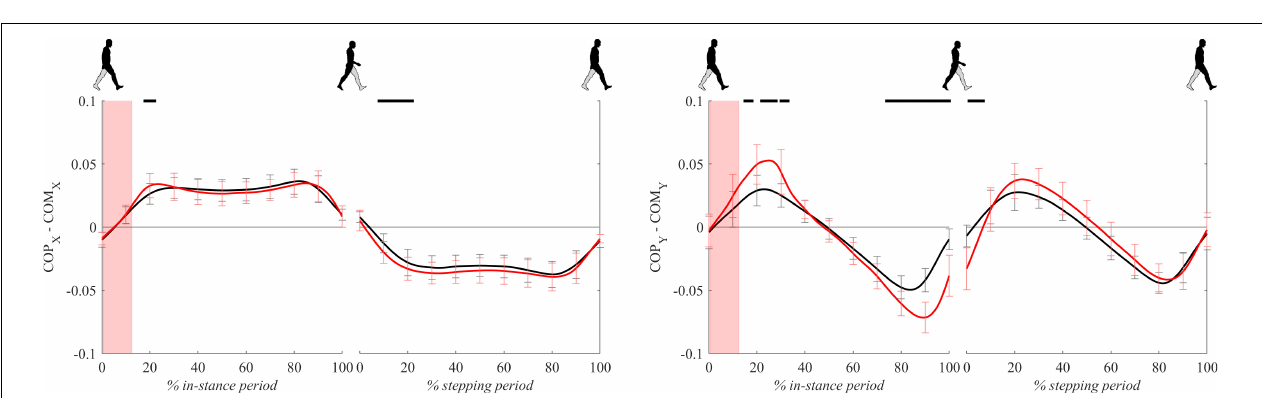
FIGURE 6 | Dimensionless group-average COP responses after outward perturbations ( N = 12). Standard deviations are shown at each 10% of a gait cycle. Black corresponds with the unperturbed experimental condition, red with perturbed experimental conditions. One gait cycle divided into the in-stance and stepping periods, normalized to its duration separately for each experimental condition, is shown following a perturbing push. To visualize normalization of both periods short discontinuity is introduced on abscise. The perturbation period is marked with the red bar. Periods where statistically significant changes were determined between both experimental conditions are indicated with piece-wise continuous black lines on top of each graph.